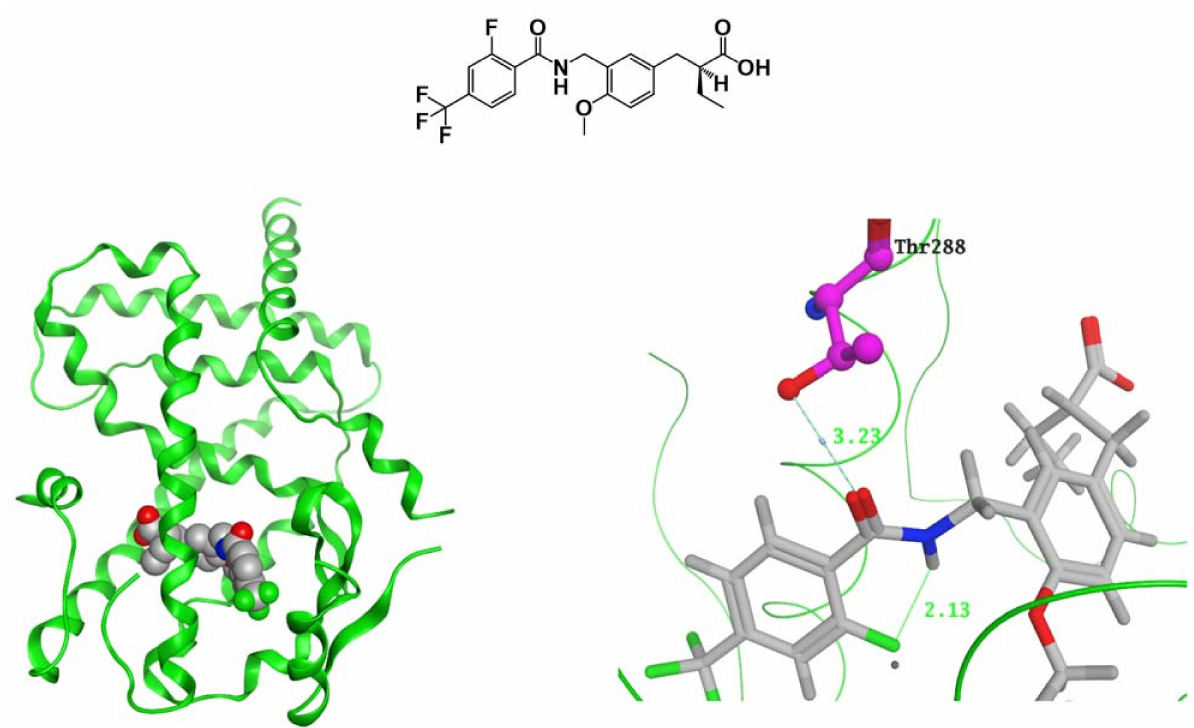
Figure 6. ( Left ) Crystal structure of TIPP-401 complexed with the PPAR δ LBD. ( Right ) Zoomed view of the tether region (CONHCH2) of TIPP-401 hydrogen bonded with 288Thr. Predicted mode of binding of the amide derivative and the reversed-amide derivative to PPAR δ . Hydrogen bonds are shown as yellow dotted